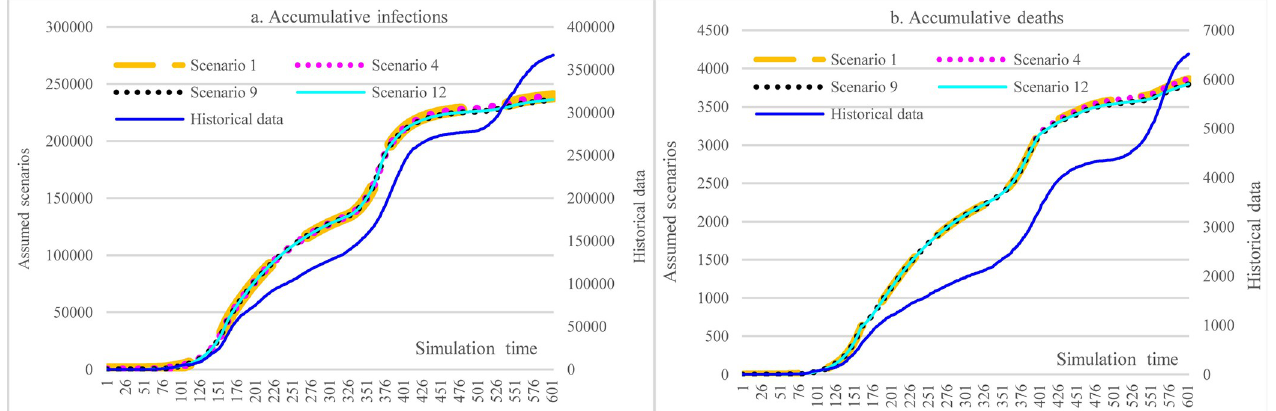
PLOS ONE | https://doi.org/10.1371/journal.pone.0271231 July 26,